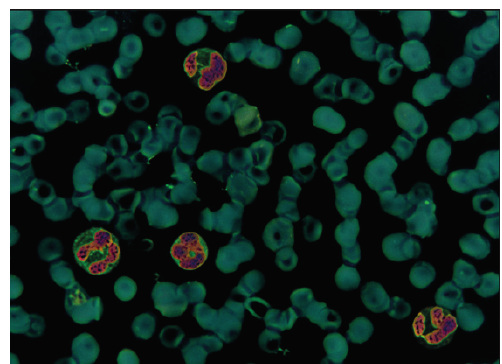
Figure 9. Enhanced